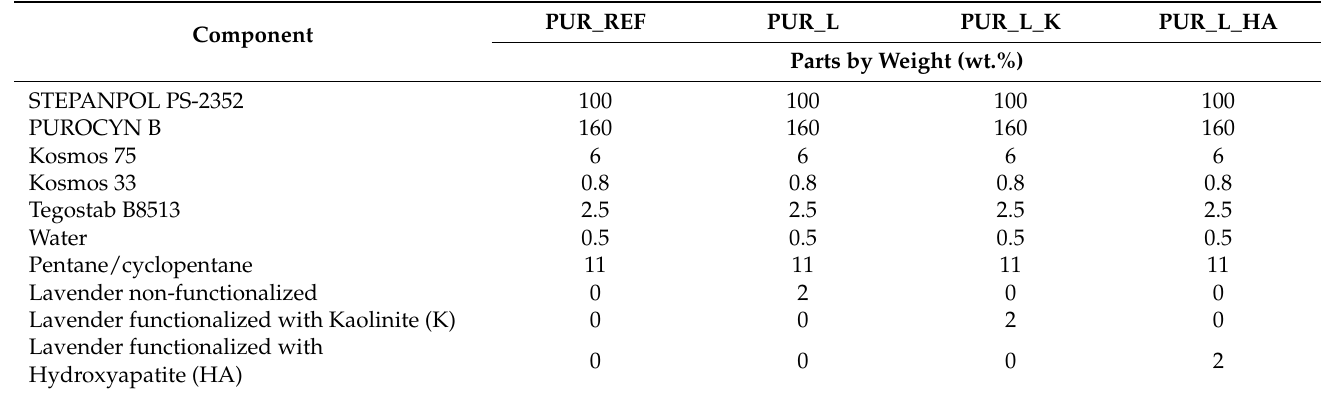
Figure 2. Schematic procedure of the synthesis of polyurethane (PUR) composites filled with non-functionalized and functionalized lavender fillers. Table 1. Composition of PUR composite foams.